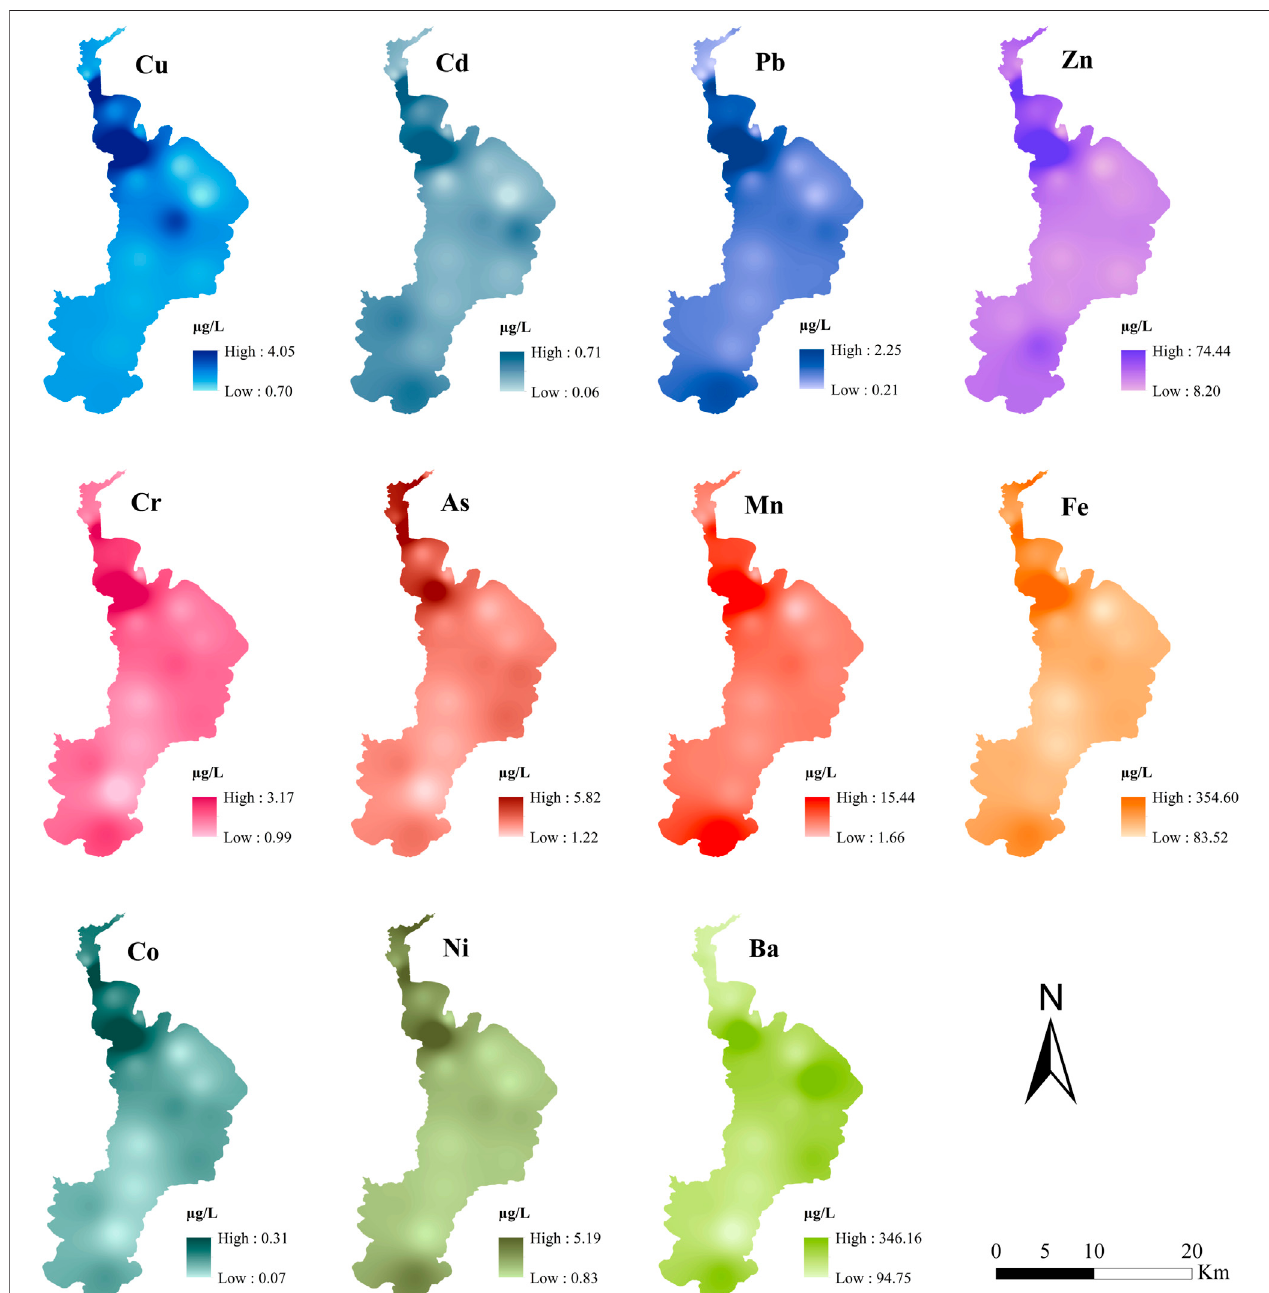
FIGURE 2 | Spatial variations of heavy metal concentration in surface water, including Cu, Cd, Pb, Zn, Cr, As, Mn, Fe, Co, Ni, and Ba. Ag was not presented because of its low concentration in surface water.